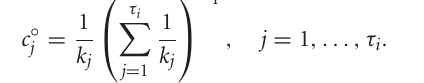
ALGORITHM 1: REDUCTION OF MONOMOLECULAR